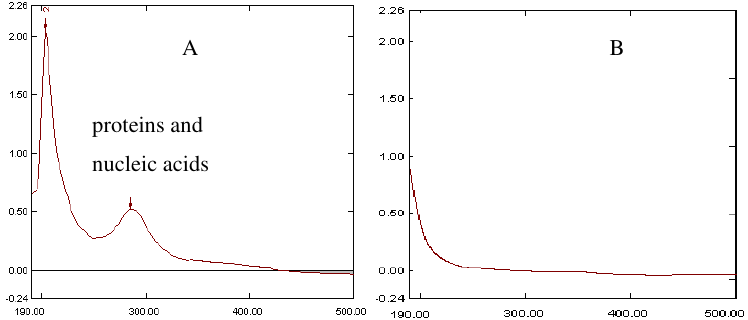
The UV absorption wavelength of proteins and nucleic acids is from 260–280 nm so this absorption peak was used to determine if the polysaccharide solution contained proteins and nucleic acids (A. Polysaccharide before protein removal; B. Polysaccharide after protein